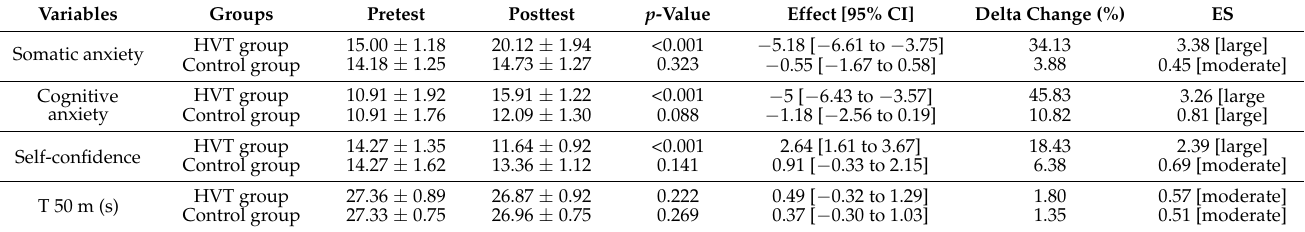
Table 2. Changes in psychological state and swimming performance between pre- and post-test after an intervention period of 4 weeks in high volume training (HVT) and a control group carrying out the standard training